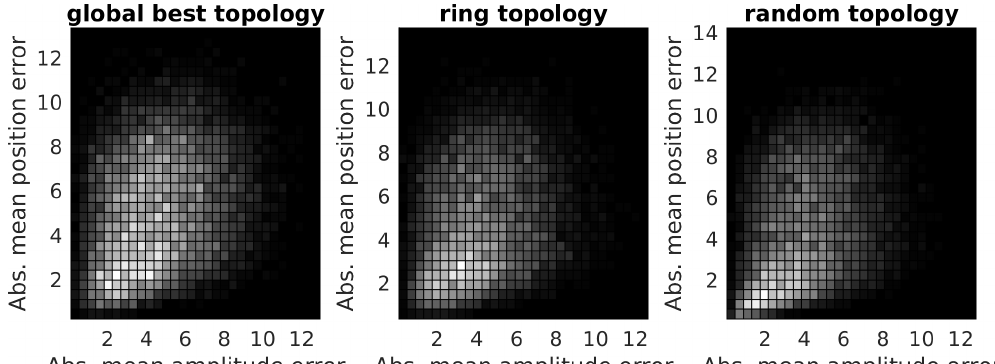
Figure 5. The relation of absolute mean amplitude error and absolute mean position error.